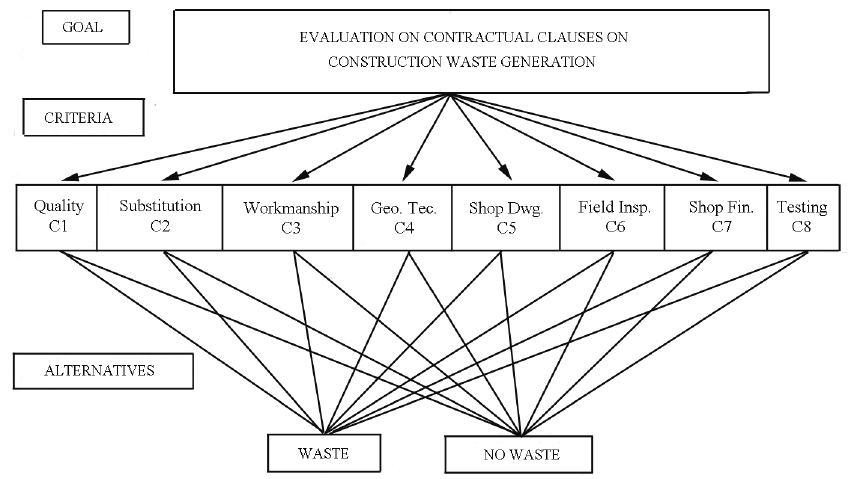
Fig. 2. Hierarchical structure of